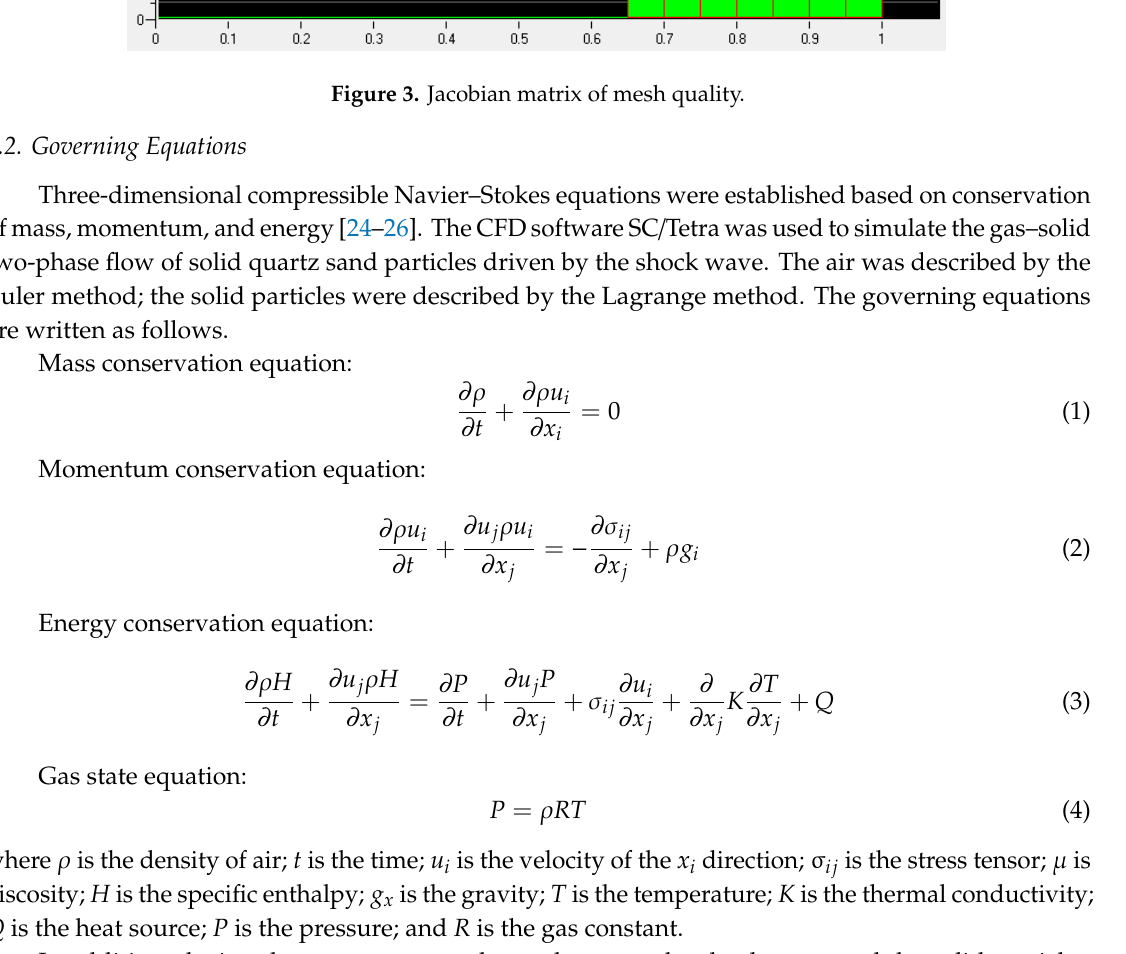
Figure 3. Jacobian matrix of mesh quality.